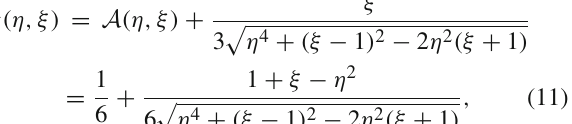
Fig. 1 Regions of the parameter space (η,ξ) that admit models of STFOG with real masses m 2 ± (cid:4) 0: { (η,ξ) | 0 (cid:3) η < +∞ , 0 (cid:3) ξ < ξ ∗ (η) }, where ξ ∗ (η) = (η − 1 ) 2